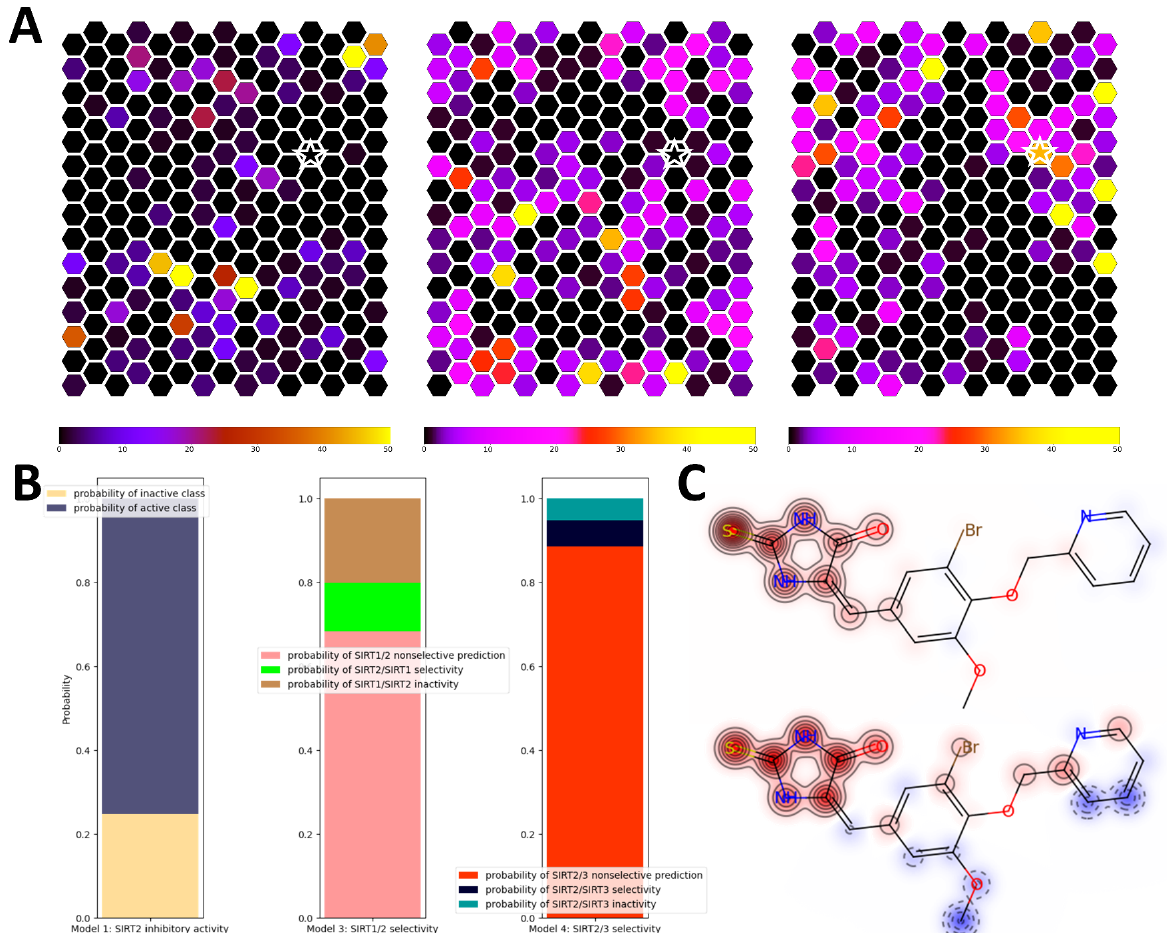
Figure 9. Comparison of SIRT2i_Predictor to the multi-structure SBVS approach. ( A ) Comparisons of the chemical space covered by ChEMBL SIRT2 inhibitors (left), SBVS virtual hits (middle), and SIRT2i_Predictor virtual hits (right); ( B ) analysis of probabilities obtained for virtual hits extracted from a unique portion of chemical space covered by SIRT2i_Predictor (star sign in ( A )); ( C ) structure–activity relationships calculated using similarity maps for a binary model (upper plot) and a regression model (lower plot) for virtual hits extracted from a unique portion of chemical space (star sign in ( A )). A red glow indicates a region that has a positive influence on the activity, whereas a blue glow indicates a negative